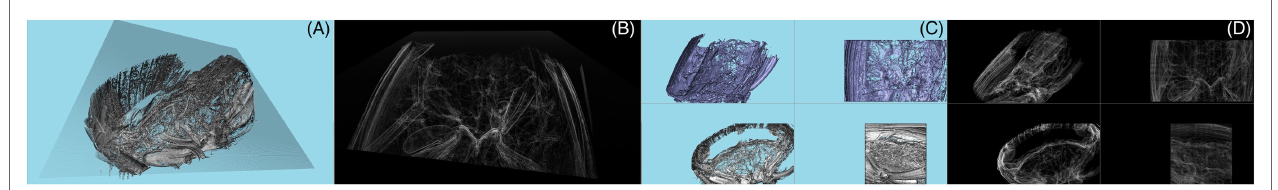
FigUre 5 | The arbitrary slicing (as) and the axis-aligned slicing (aas) interfaces – (a) as: opaque mode, (B) as: X-ray mode, (c) aas: opaque mode, and (D) aas: X-ray mode